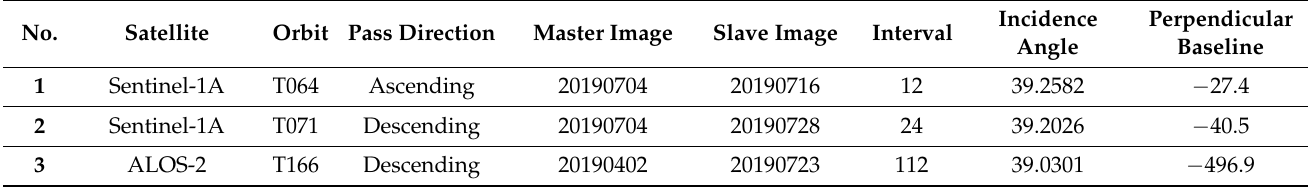
Table 2. Co-seismic interference pair parameters.